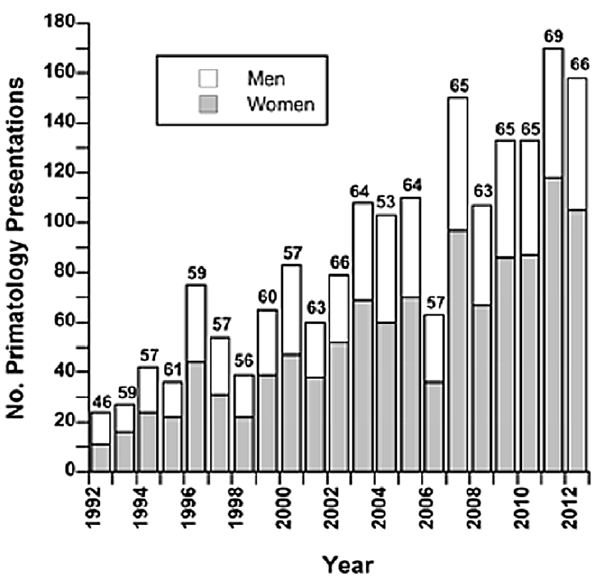
Figure 1. Numbers of presentations in primatology by men and women as first authors at AAPA meetings. Values come from annual meeting issues of the American Association of Physical Anthropologists from 1992–2012. Values above bars are percentages of presentations by women as first authors.